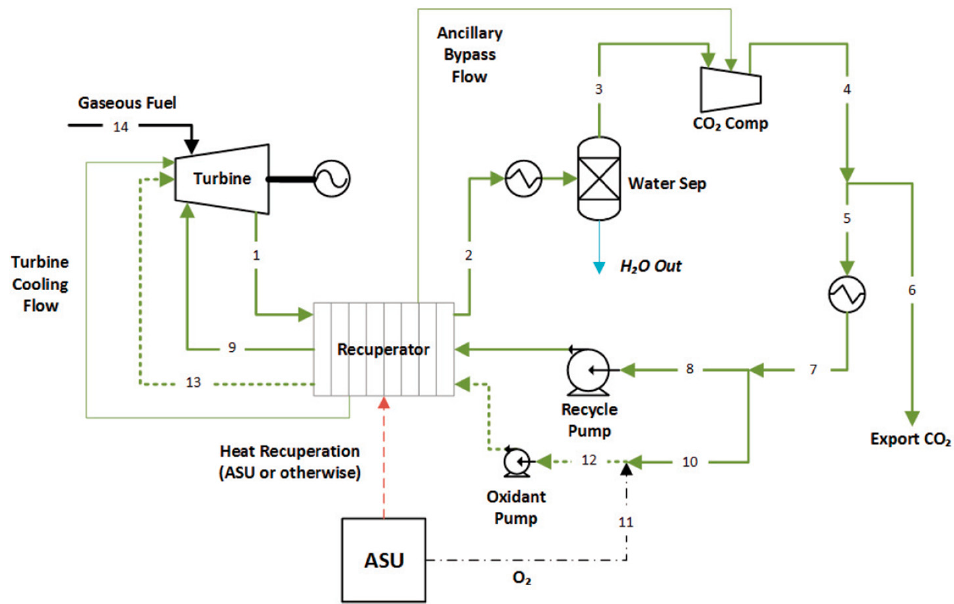
Figure 1. Layout of a simplified commercial-scale natural gas Allam cycle [21], with stream num- bers.